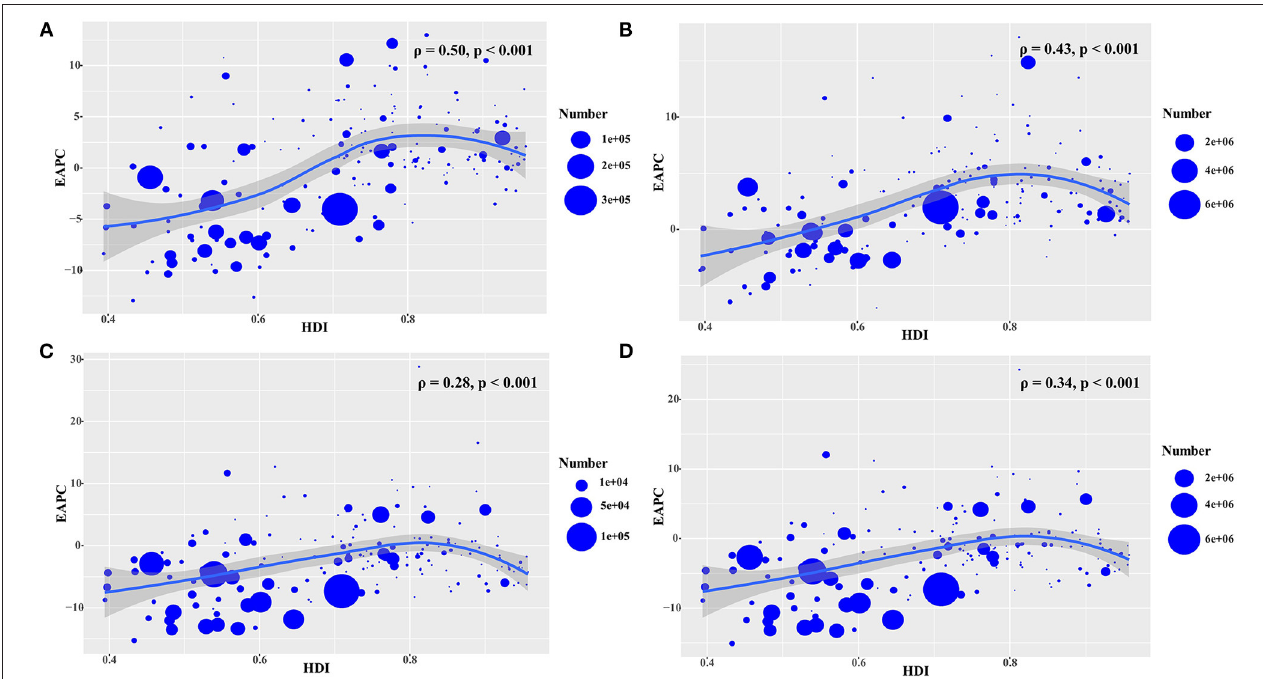
FIGURE 5 | The association between EAPCs and HDI in 2019 at the national level during the period 2005–2019. The EAPCs of HIV/AIDS including the incidence (A) , prevalence (B) , death (C) , and DALYs (D) showed a positive association with the corresponding HDI in 2019. The associations were calculated using Pearson correlation analysis. The circles represent countries with available HDI data, and the size of the circles change according to the number of HIV/AIDS cases in the corresponding countries in 2019. EAPC, estimated annual percentage change; HDI, human development index.